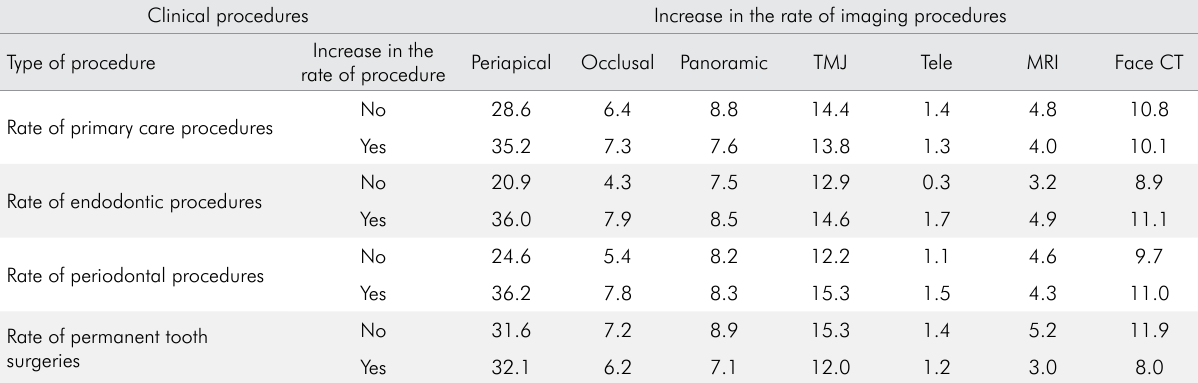
Table 4. Percentage of municipalities that increased the rates of imaging procedures per 100,000 inhabitants from 2005–2007 to 2014–2016 according to clinical procedures (n =